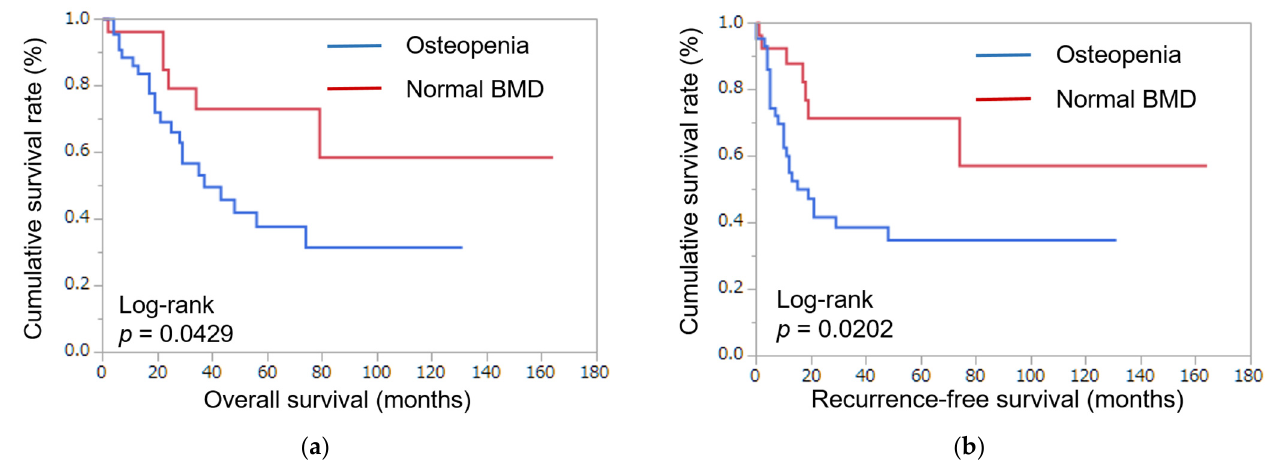
Figure 1. Patient survival. ( a ) Postoperative overall survival, classified by bone mineral density. ( b ) Postoperative recurrence-free survival, classified by bone mineral density. Normal BMD was better than osteopenia in five-year overall survival and recurrence-free survival in patients with ICC.